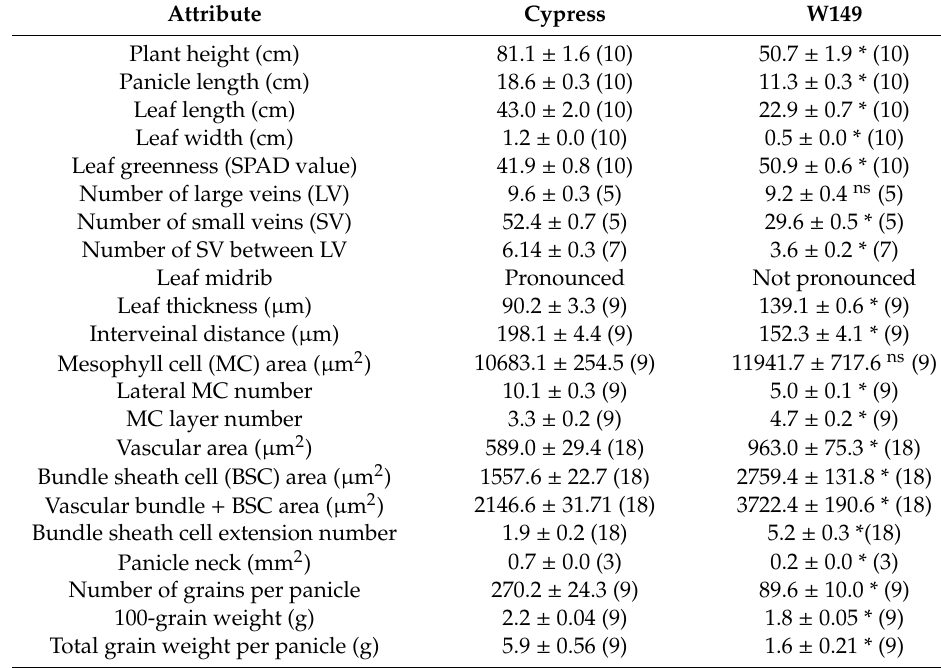
Table 1. Phenotypic characteristics of Cypress and W149 mutant. The mean value of each attribute is indicated by the mean ± standard deviation and sample size is indicated in parentheses. Asterisks indicate significant di ff erences between Cypress and W149 mutant, as determined by Student’s t